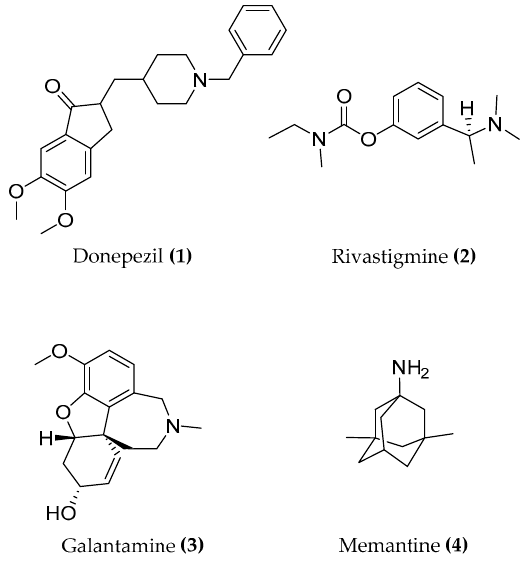
Figure 1. Structures of donepezil, rivastigmine, galantamine and memantine.